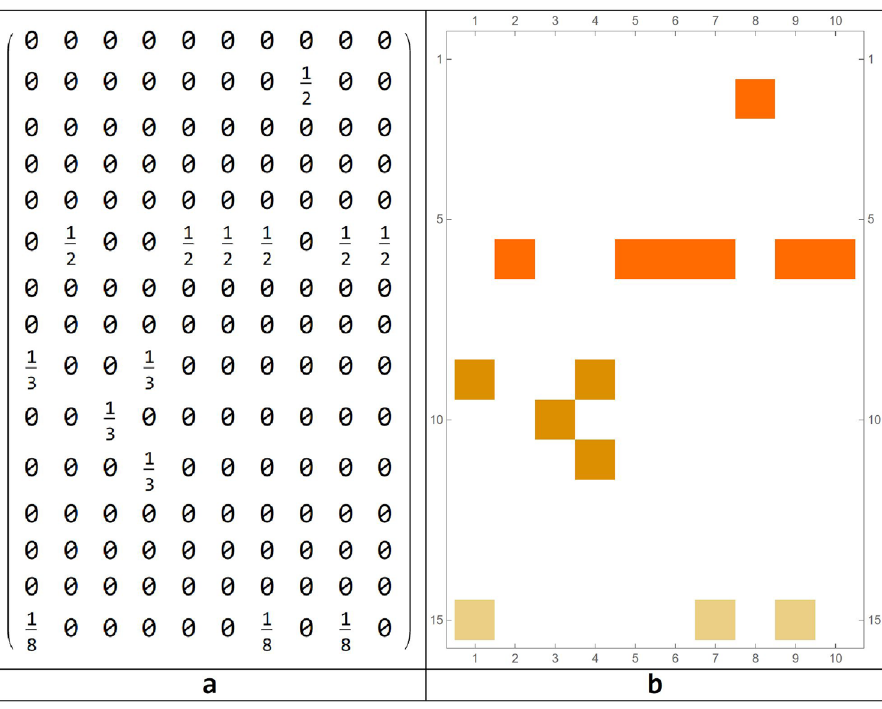
Figure 14. Intersection array ( a ) and correlation matrix for different simulation parameters ( b